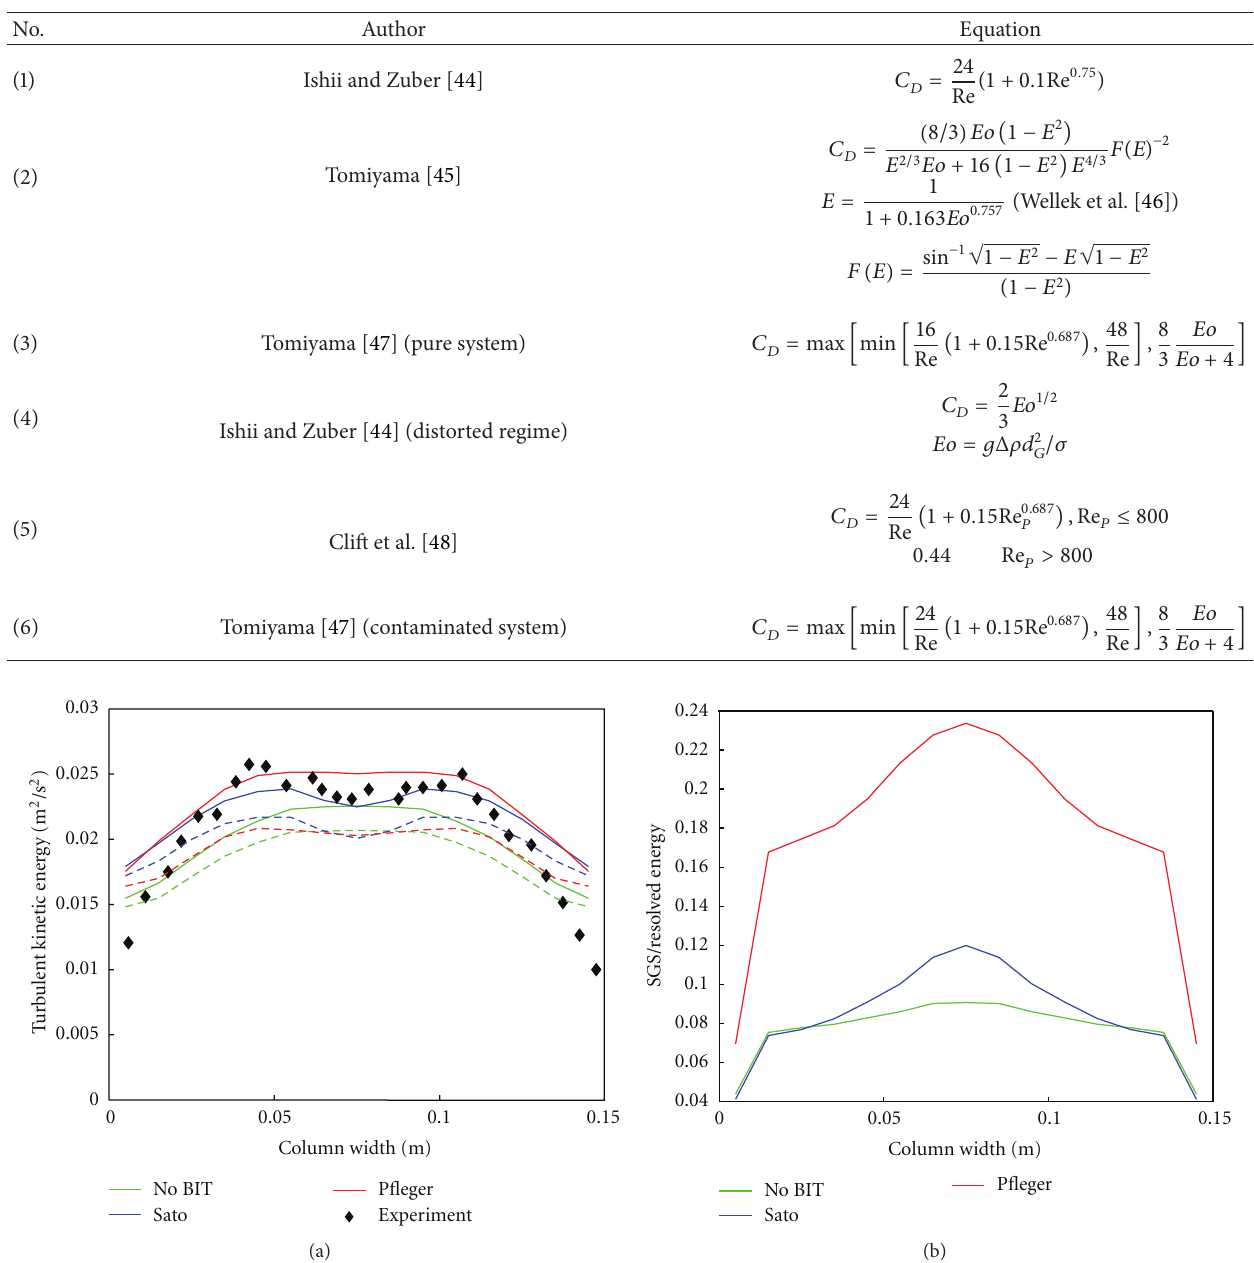
Table 3: Drag force models.